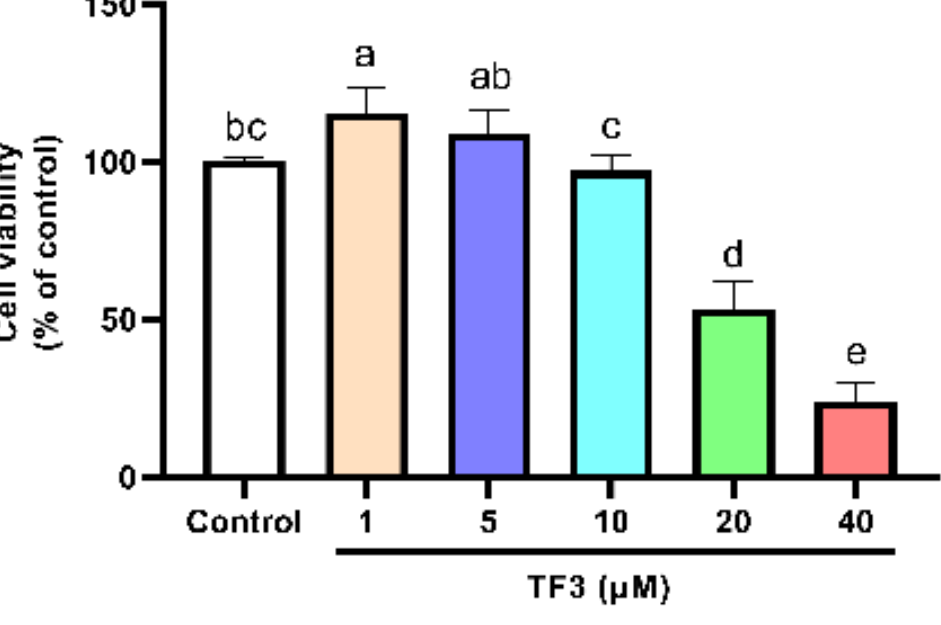
Figure 2. Viability of H9c2 cells treated with different concentrations of TF3. Significant differences between different treatments were shown by different letters ( p < 0.05) .